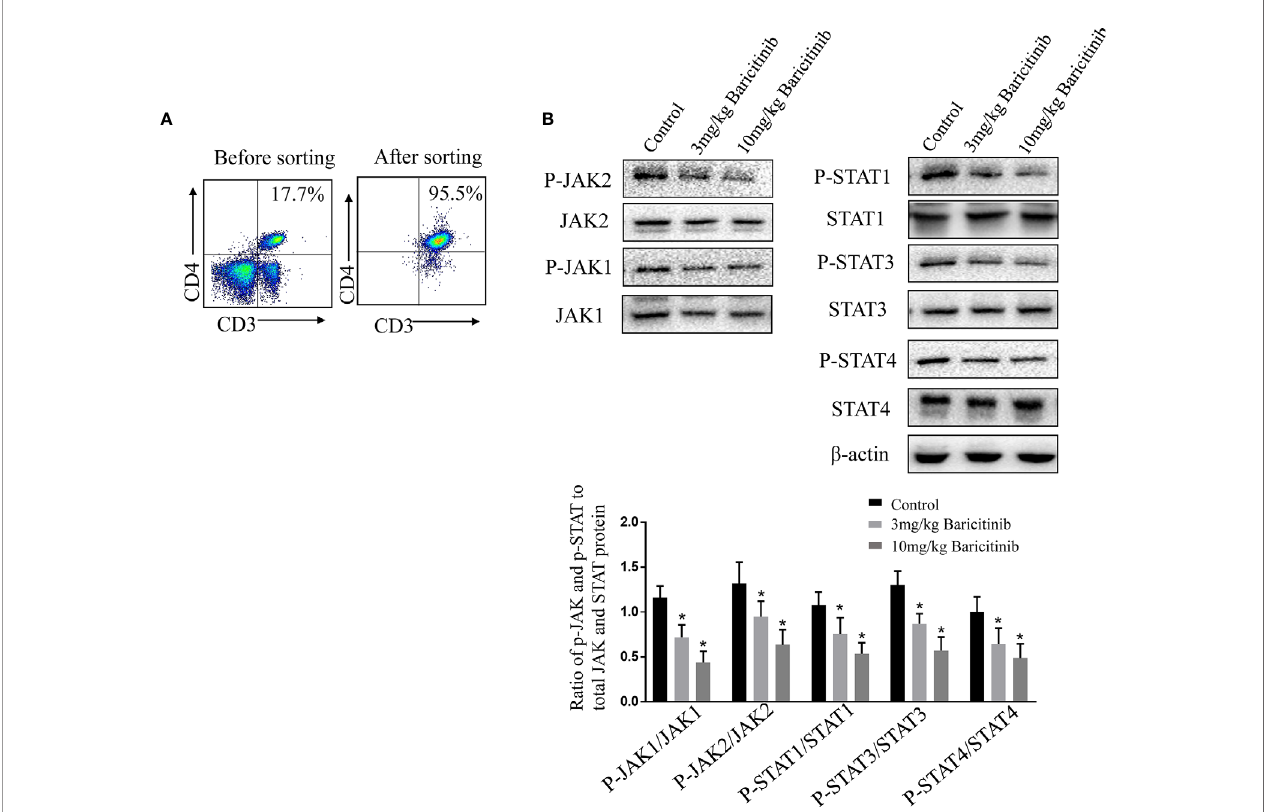
FIGURE 6 | Baricitinib causes a CD4+ T cell phenotype shift by inhibiting the JAK/STAT pathway. (A) Representative fl ow cytometry plots show naive CD4+ T cells from the spleens were puri fi ed with magnetic microbeads, producing a purity of ≈ 95%. (B) Ratio of p ‐ JAK and p ‐ STAT to total JAK and STAT protein. Puri fi ed CD4+ T cells isolated from vehicle or baricitinib-treated EAE mice were restimulated with MOG 35-55 peptide (10 m g/mL). Western blot analysis of phosphorylated and total JAK1, JAK2, STAT1, STAT3, and STAT4 proteins were detected by immune-blotting. Total JAK1, JAK2, STAT1, STAT3, STAT4, and b -actin proteins as loading control were detected by immunoblotting. Quantitative data are the mean ± SEM. * p < 0.05; n = 6 per group. SEM, standard error of the